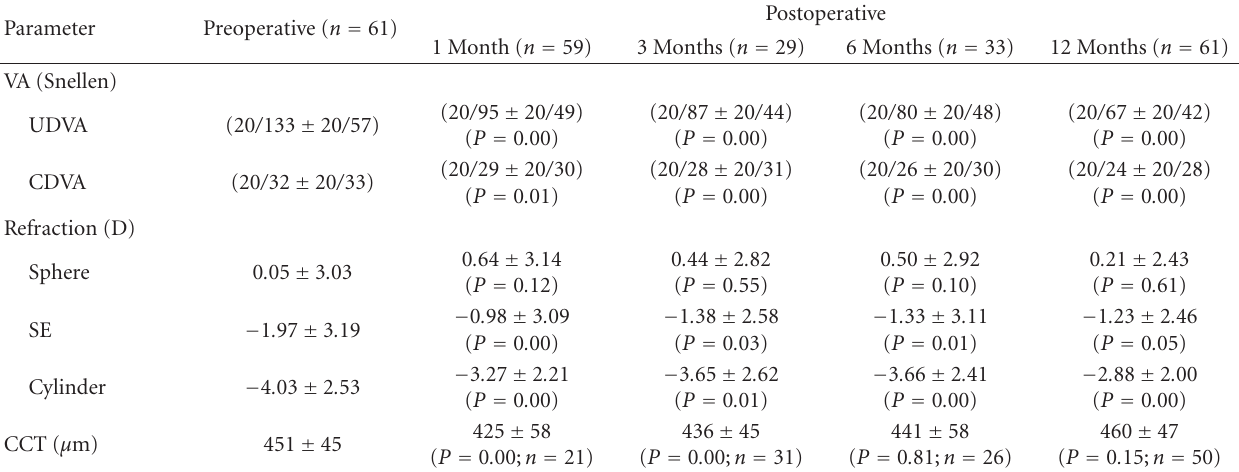
Table 1: Visual acuity, refraction, and corneal thickness changes during 1-year followup.